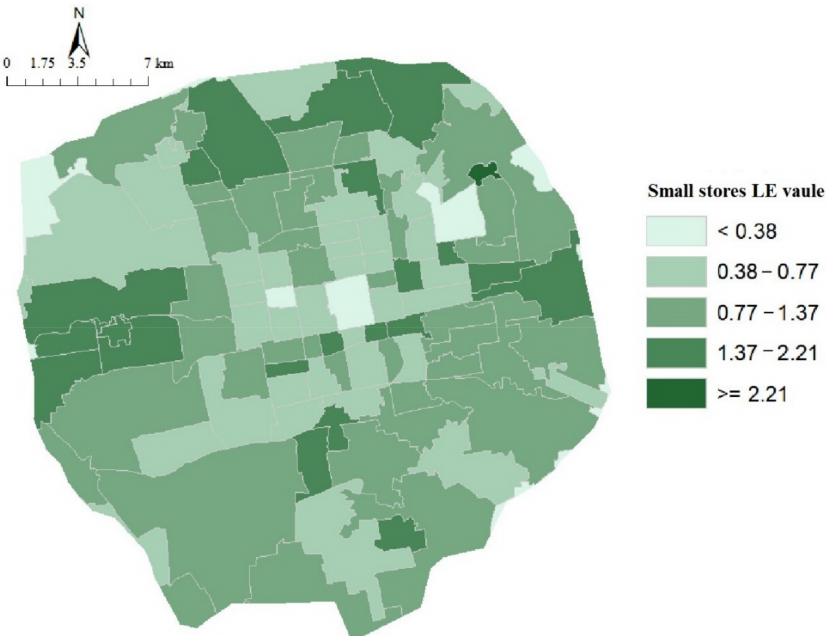
Figure 9. Distribution of the small store locational entropy values for streets within the Fifth Ring Road in Beijing.